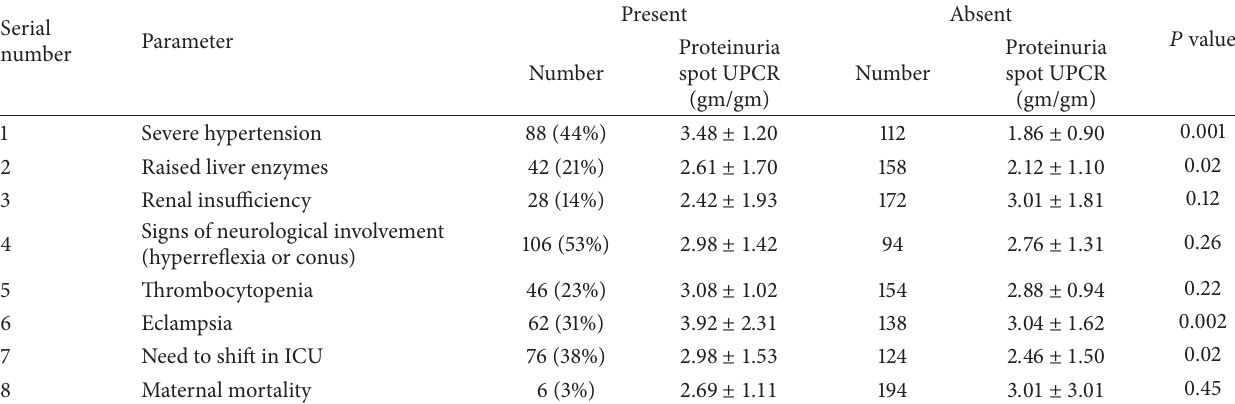
Table 2: Frequency of maternal complications and spot UPCR in the patients of preeclampsia.